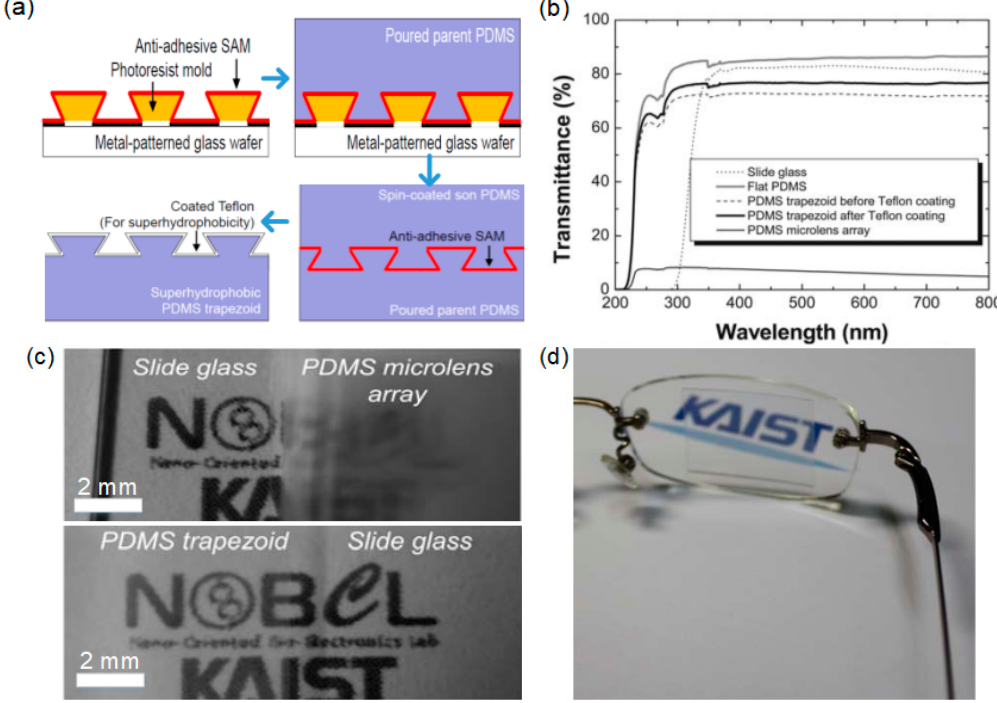
Figure 8. ( a ) Schematic diagrams of the two consecutive PDMS replication processes; ( b ) Transmittance characteristics of various samples as a function of the wavelength of the incident light; ( c ) Photographs of logos underneath the superhydrophobic PDMS trapezoids array and the superhydrophobic PDMS microlens array; ( d ) A photograph of the PDMS trapezoids sample on one eyeglass lens. Reproduced from [64] with permission; Copyright RSC 2010.